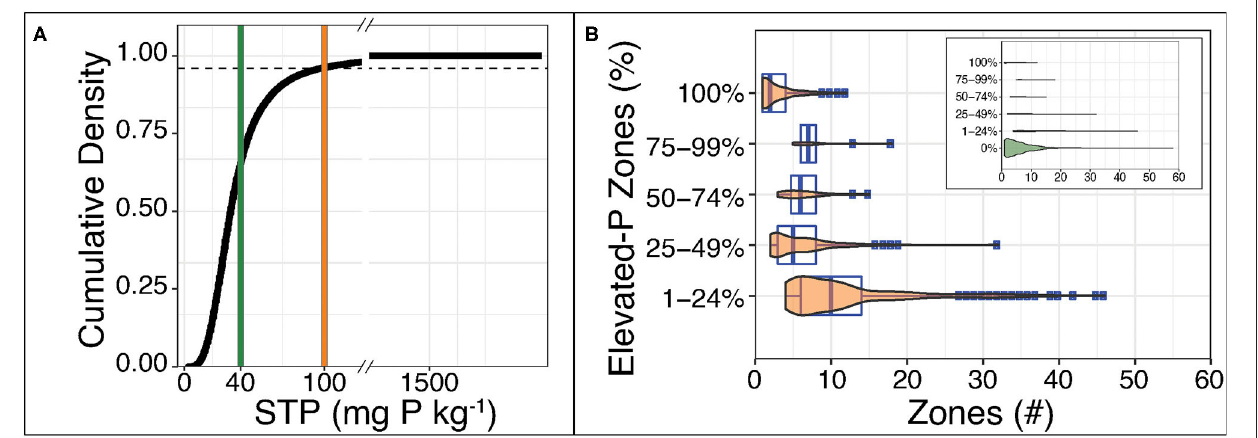
FIGURE 2 | (A) Distribution of soil test phosphorus (STP) values (in Mehlich-3 equivalents) across fields in the combined data provided by AR_1 and AR_2. The black line shows the cumulative density of STP concentrations. Vertical lines highlight the concentrations for the recommended agronomic need (40mg P kg − 1 soil; green) and the threshold set for defining elevated-P fields in the region (100mg P kg − 1 soil; orange). (B) Percent of zones with elevated-P compared to the total number of zones on the field. Violins are scaled such that the area within each violin is representative of fields in that category. The inset graph includes the relative number of fields without any elevated-P zone. Violins are underlain by boxplots to show the median, interquartile range, and